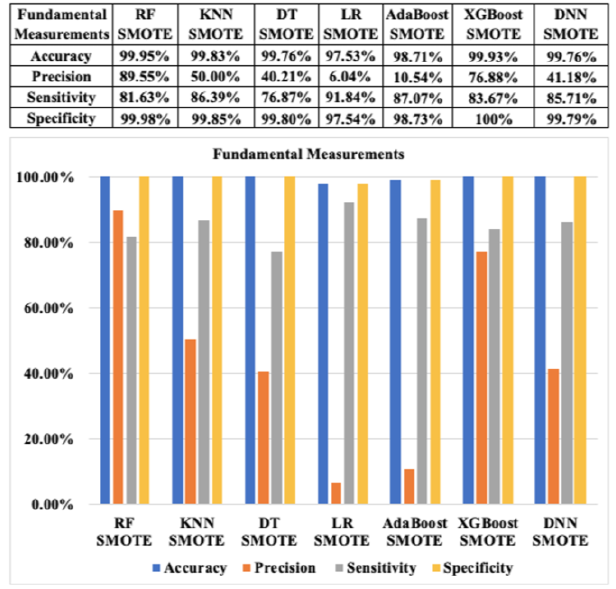
Figure 18. Fundamental classification performance measurements of ML algorithms with SMOTE based on resampling approach 2.